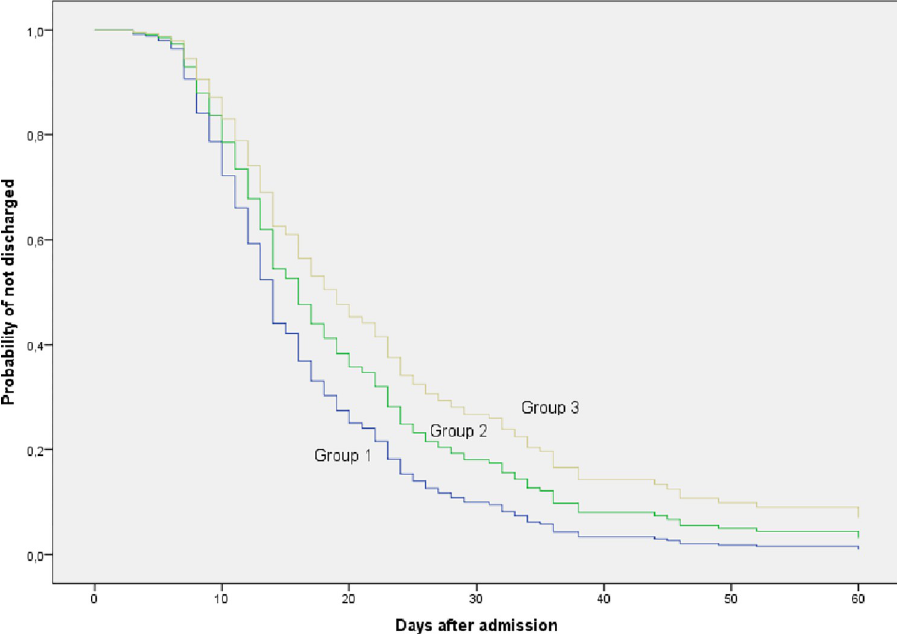
Fig 6. Probability of remaining as an inpatient at 60 days in the different treatment groups.